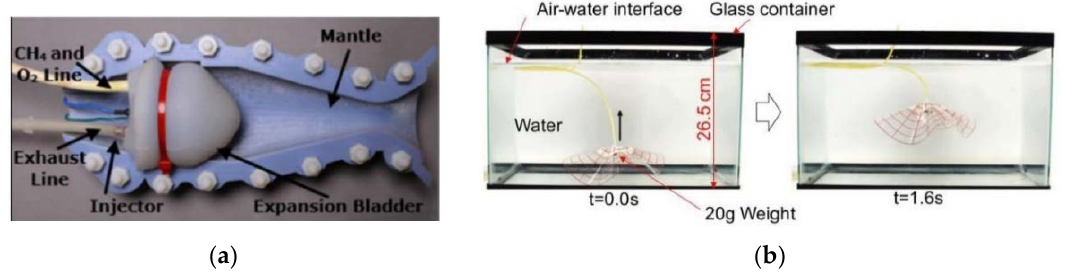
Figure 8. Other fluid-driven aquatic robots: ( a ) A cephalopod-inspired combustion engine for jet propulsion fish [96] , reproduced with permission from [96] , 2018, Elsevier; ( b ) light-weight jellyfish animal [98] , reproduced with permission from [98] , 2021, PNAS.